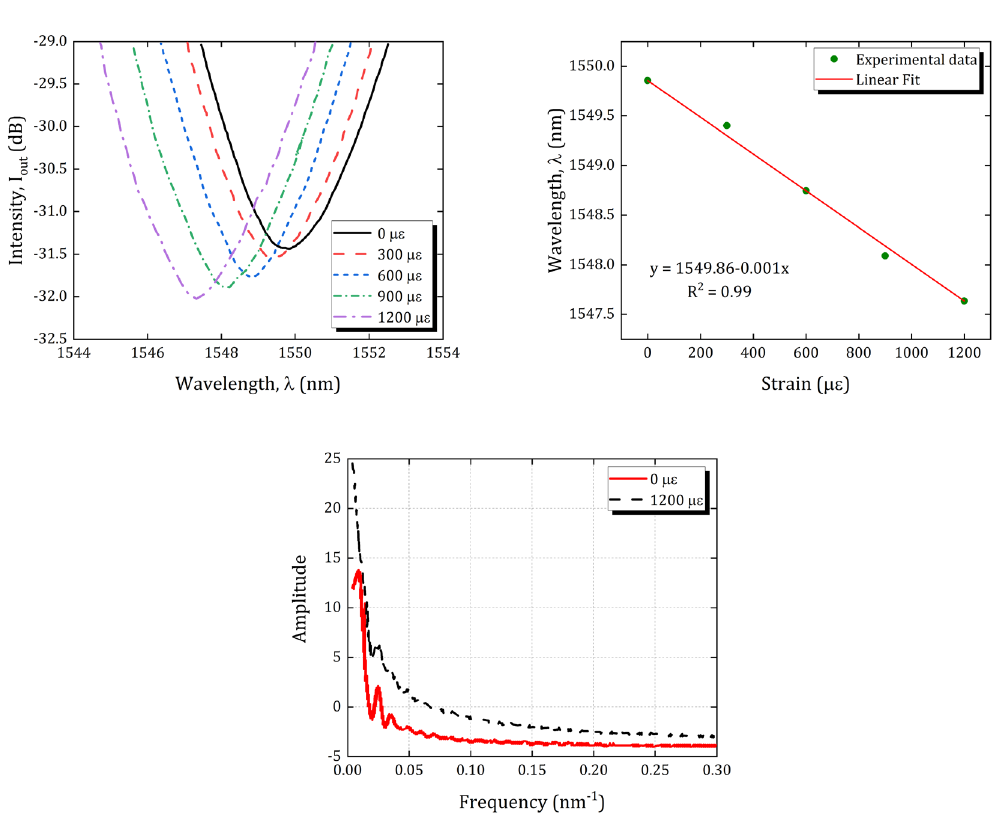
Figure 5. ( a ) The output intensity of PCF-MZI as a function of wavelength, ( b ) The wavelength shift as a function of the axial strain, and ( c ) The effect of axial strain on the spatial frequency